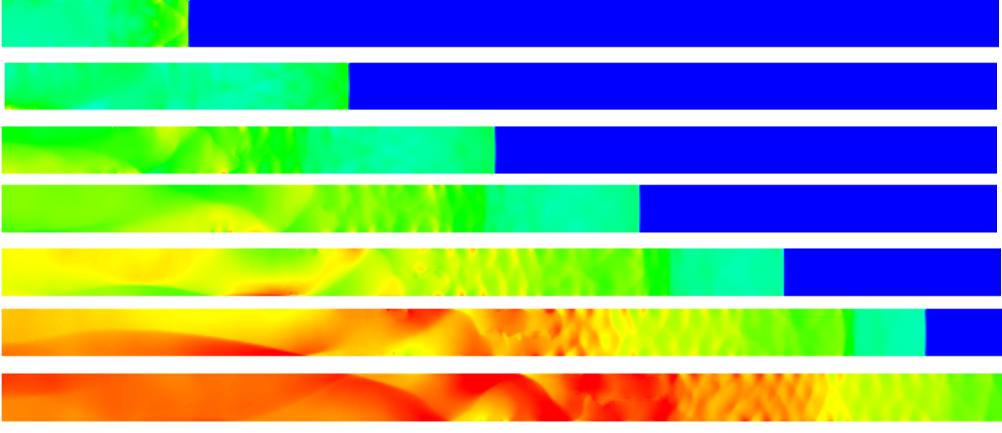
Figure 5 Distribution of the pressure in the same case as Figure 4